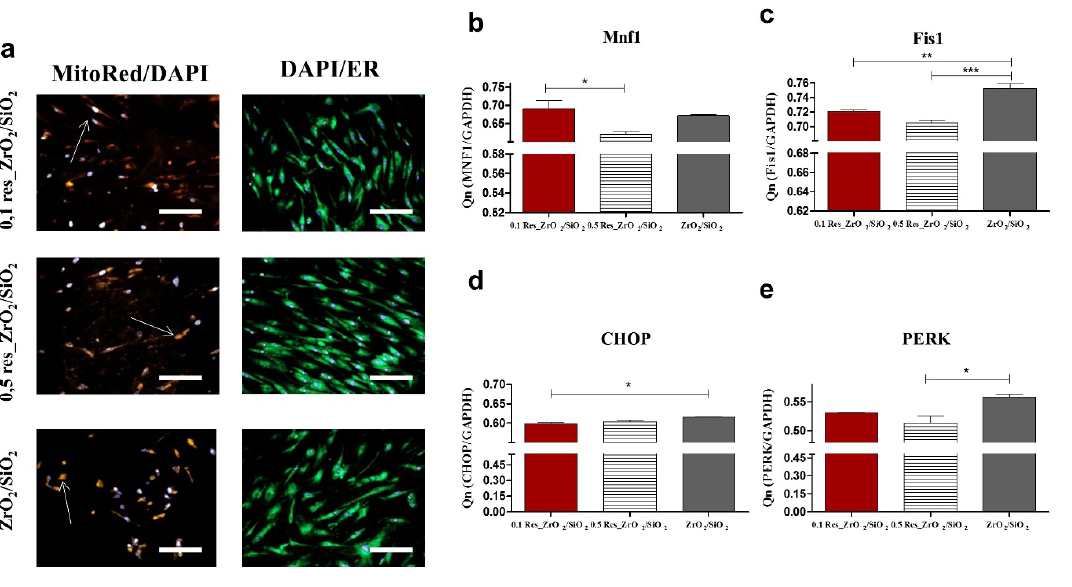
Figure 6: Morphology of mitochondria and endoplasmic reticulum of ASCs estimated with DAPI/MitoRed and DAPI/ER staining (a). Arrows indicate mitochondria of cells cultured on different sol/gel coatings. Expression levels of the Mnf1 (c) and Fis1 (d) genes in order to assess the balance between fission and fusion which regulates the mitochondrial dynamics. Moreover, CHOP (d) and PERK (e) mRNA levels were estimated in order to examine the condition of endoplasmic reticulum. Magnification: x100. Scale bar 250 µm. Results expressed as mean ± SD *pvalue<0.05,. **pvalue<0.01,